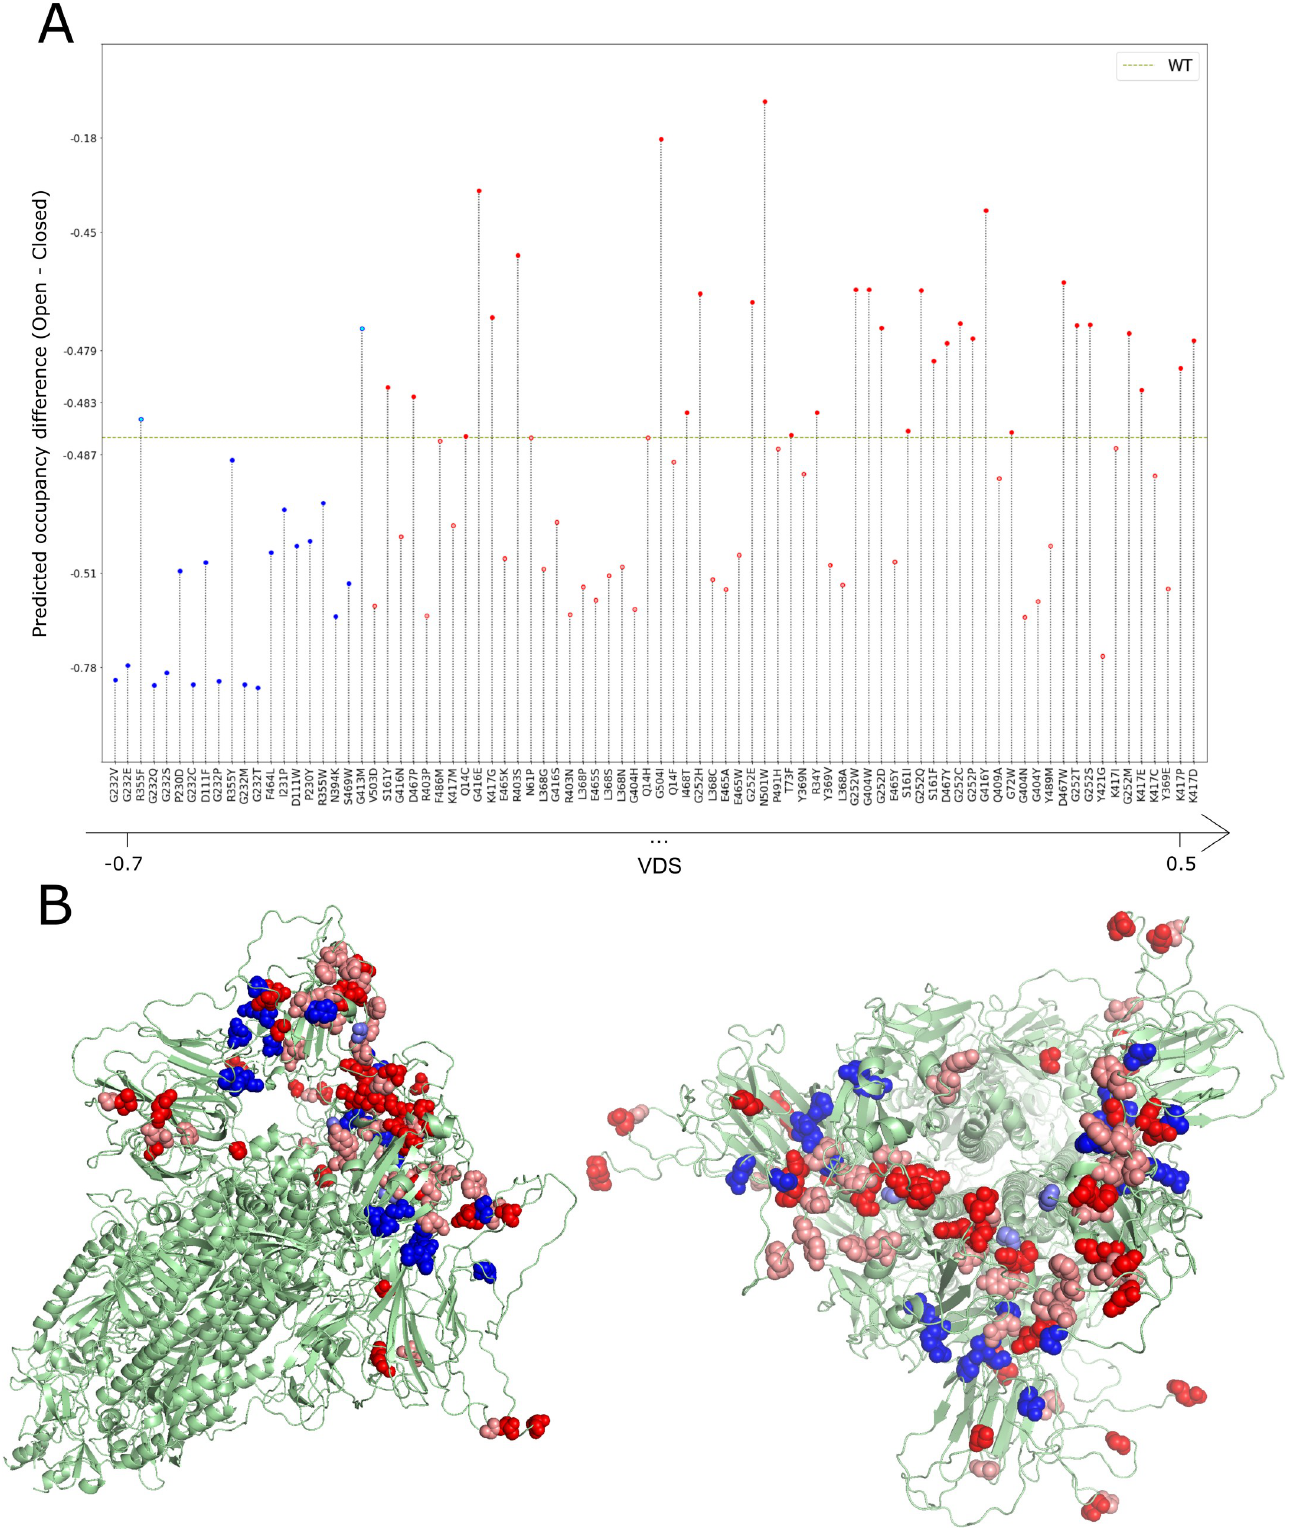
Fig 9. (A) Difference in the occupancies for the open and the closed states for the top 64 mutants with VDS > 0.3 (red) and the 20 mutants with lower VDS (blue). Occupancy difference for the WT is represented by the dashed green line. Y-axis based on the transformation of a symmetric logarithmic scale. (B) Two